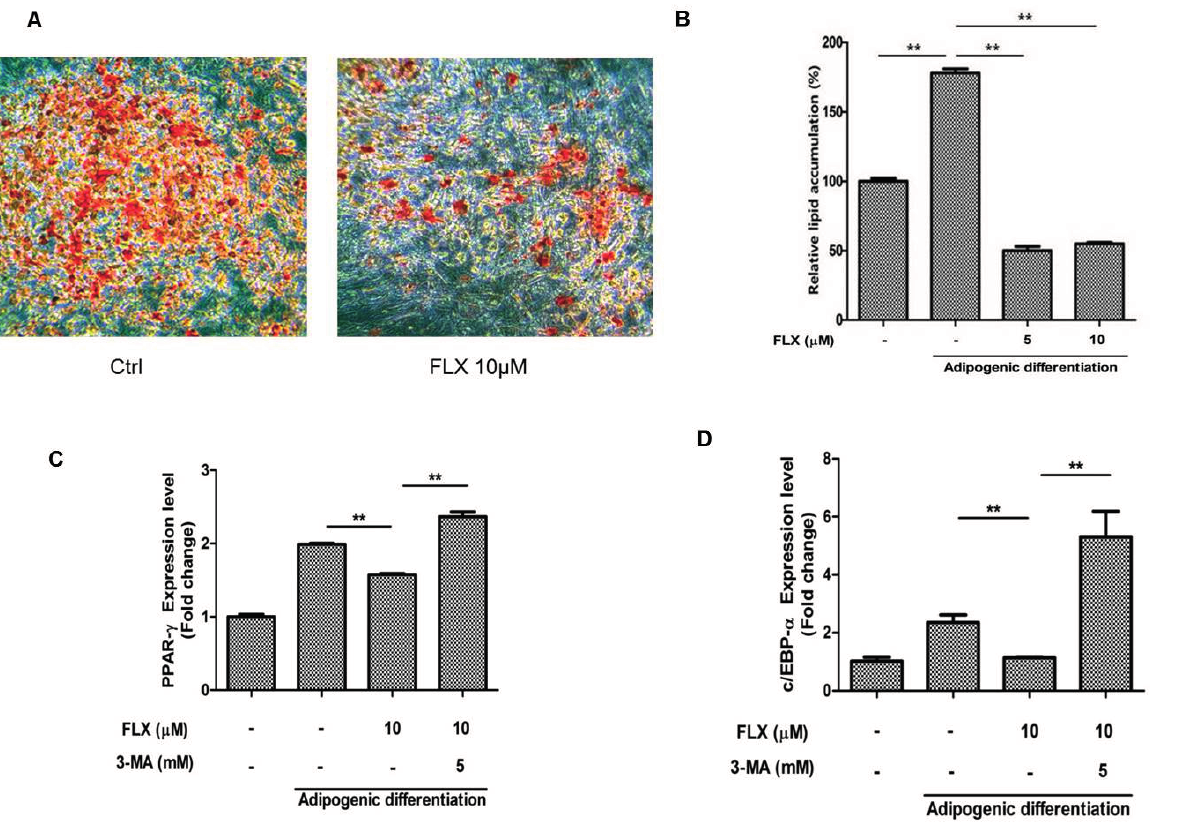
Figure 5. Fluoxetine decreased the adipogenic differentiation of ASCs. ( A ) ASCs were cultured in adipocyte induction medium for two weeks, stained using Oil Red O, and microscopic images are taken, 40×; ( B ) Fluoxetine significantly reduced the lipid accumulation in adipocyte induction medium; ( C ) Fluoxetine decreased the levels of adipogenic differentiation markers, peroxisome proliferator-activated receptor- γ (PPAR- γ ) at day 7, but the autophagy inhibitor 3-MA significantly attenuated the mRNA levels of PPAR- γ ; ( D ) Fluoxetine decreased the levels of adipogenic differentiation markers, CCAAT-enhancer-binding proteins- α (C/EBP- α ) at day 7, but 3-MA significantly reversed the effect of fluoxetine on C/EBP- α mRNA levels, as detected by quantitative real-time PCR. GAPDH was used for normalization. All values are presented as a mean ± STD ( n = 3). ** p <